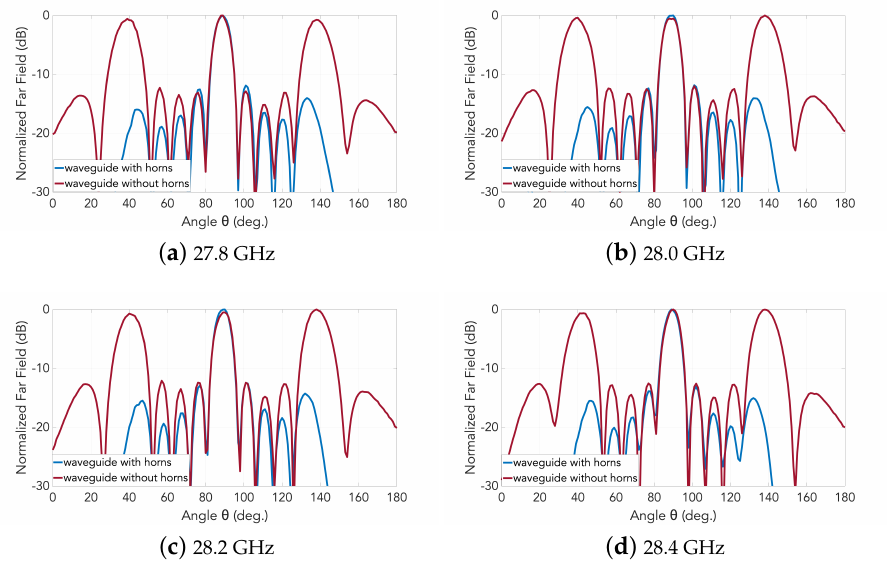
Figure 15. Measured normalized radiation patterns in E-plane of the 2D transverse waveguide slot array with and without horns: ( a ) 27.8 GHz; ( b ) 28.0GHz; ( c ) 28.2 GHz; and ( d ) 28.4